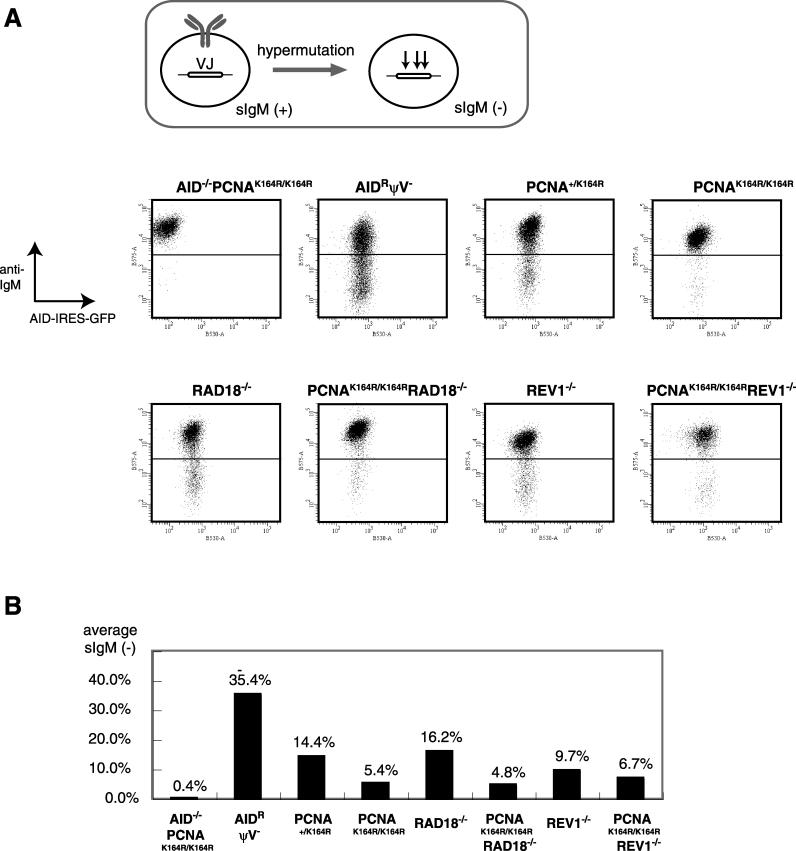
FACS Analysis of Ig Hypermutation Activity(A) FACS profiles of representative subclones derived from a sIgM (+) cell after staining with a monoclonal antibody to IgM. (B) The average percentages of events falling into sIgM (−) gates based on the measurement of 24 subclones are shown by graph.